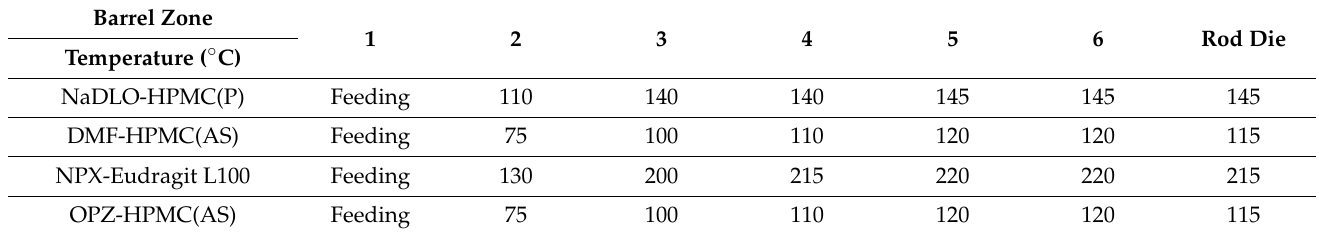
Table 1. Temperature profile used for HME of various API polymer